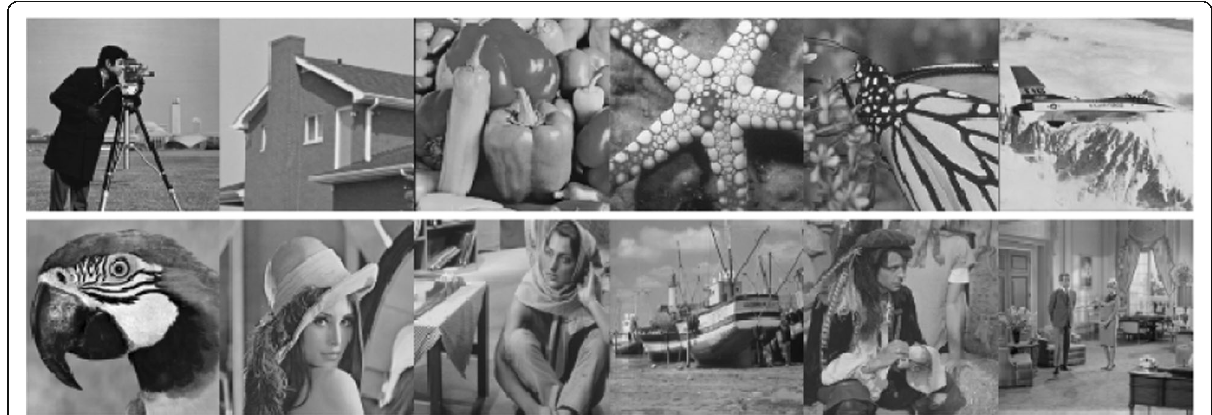
Fig. 1 Twelve test images from Set12